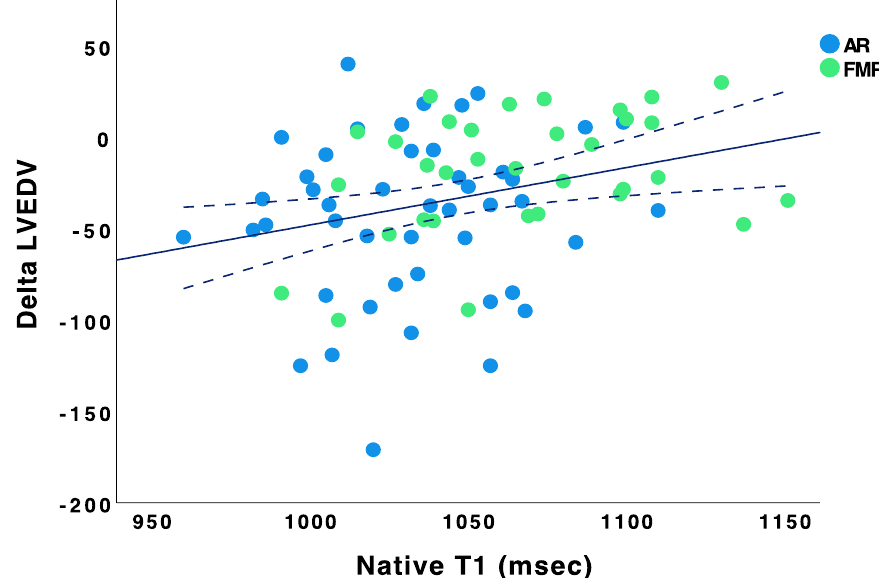
Figure 2. Correlation of native T1 with ∆LVEDV. Scatter plot showing correlation of myocardial native T1 with ∆LVEDV (Pearson r = 0.291, p = 0.009). ∆LVEDV was calculated by six months value of LVEDV (mL) minus baseline value of LVEDV (mL). AR patients are blue and FMR patients are green marked.